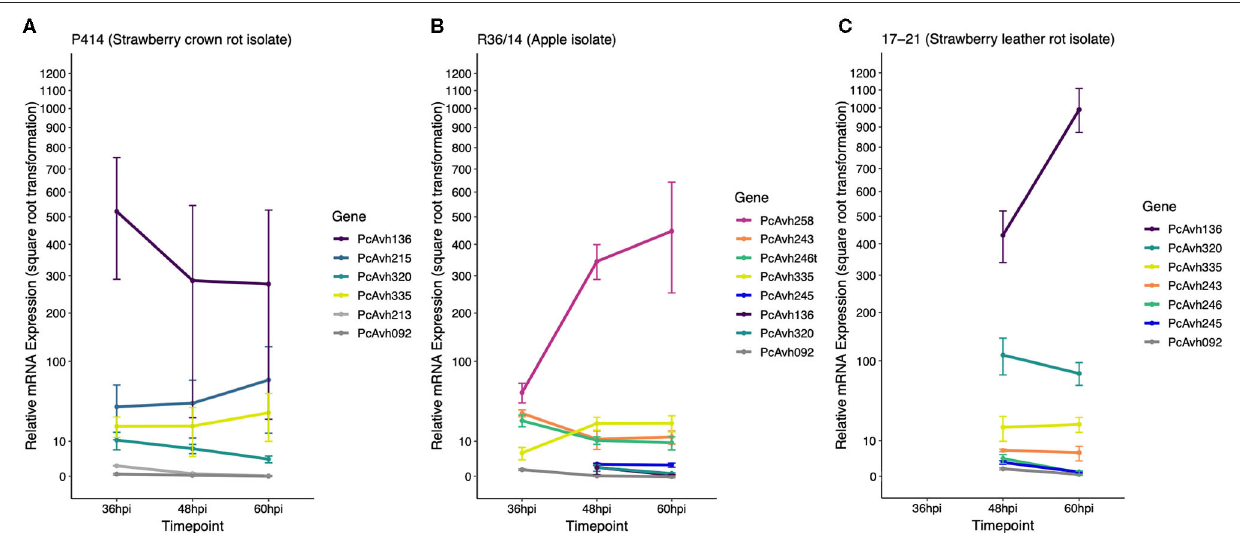
FIGURE 6 | P414, R36/14, and 17–21 RxLR genes show differential expression upon infection of strawberry fruit. (A–C) Relative expression of a selection of candidate RxLR genes in three representative Phytophthora cactorum isolates. The same gene from different genomes are indicated by the same colour. Genes of interest were normalised to two endogenous reference genes, a ribosomal 40S protein and a protein of the BAR-domain family, Pc_WS41 ( Yan and Liou, 2006) and were plotted relative to the expression of the gene of interest in mycelia. Data are the mean of three biological replicates ± se. (A) P. cactorum isolate P414, strawberry crown rot pathotype representative, (B) P. cactorum isolate R36/14, apple pathotype representative, (C) P. cactorum isolate 17–21, strawberry leather rot pathotype